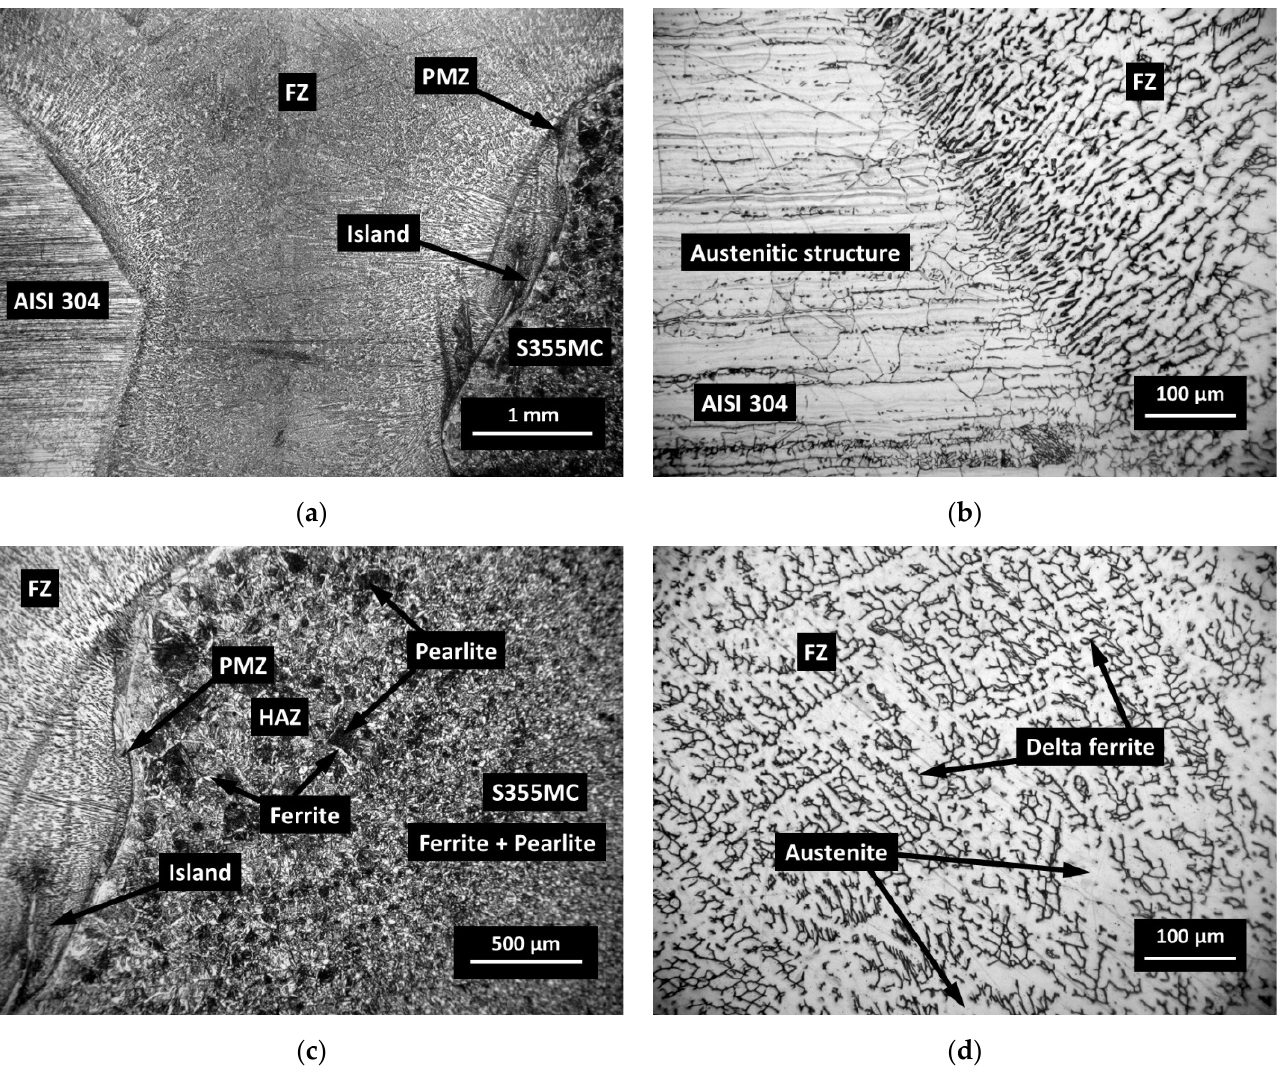
Figure 6. Optical images of different zones of welded sample AISI 304/S355MC: ( a ) general view; ( b ) partially melted zone AISI 304/FZ; ( c ) partially melted zone FZ/S355MC; ( d ) delta ferrite and austenite in FZ.